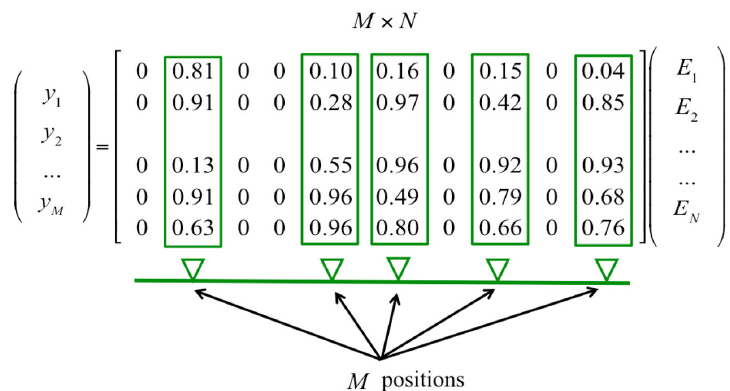
Figure 2. Definition of the M variables y m . The number different from zero in the matrix are selected randomly between 0 and 1.